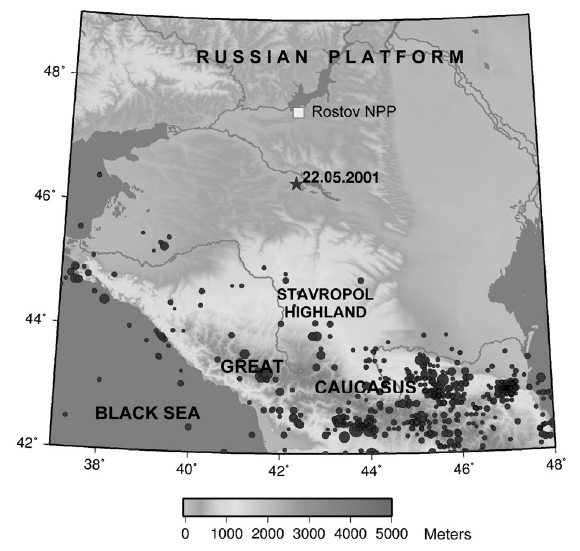
Fig. 8. Seismic setting of the 22 May 2001 Salsk earthquake from Tatevossian et al. (2002). Earthquake epi- centres are plotted according to the Earthquake catalogue of Northern Eurasia (Ulomov, 1993) (circle size is pro- portional to earthquake magnitude).